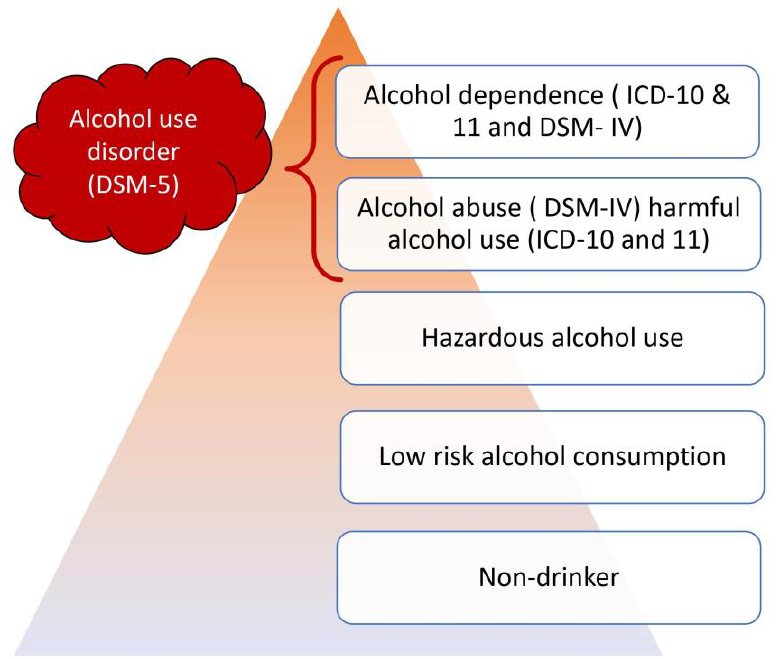
Figure 1. Differences and similarities in different classifications.